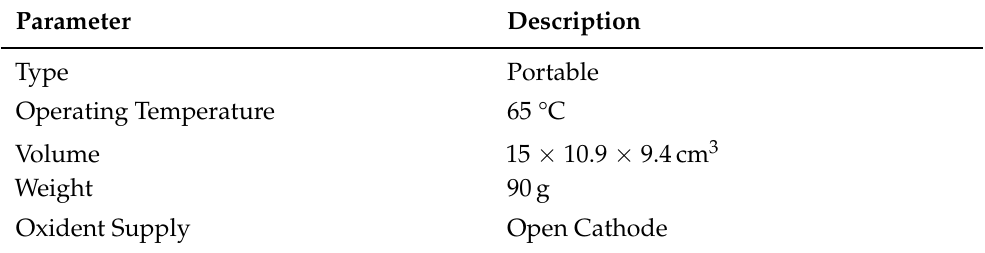
Table 2. Specifications of the Horizon Fuel Cell Technologies’ produced fuel cell used in this research.